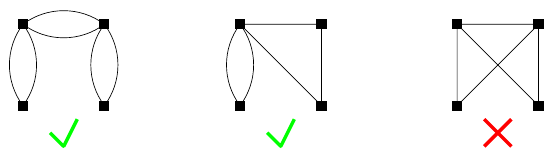
Figure 5 . Examples of diagrams going as (cid:15) 3 and sub-leading